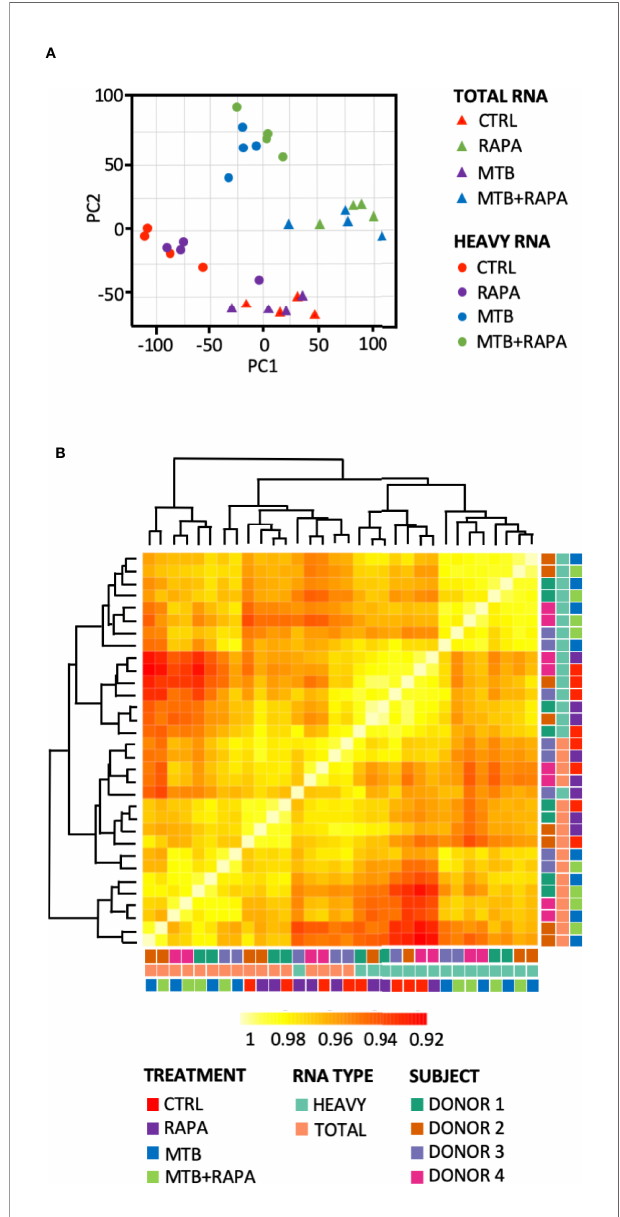
FIGURE 1 | Analysis of transcriptome and translatome of human DC infected with Mtb and treated with rapamycin. DC isolated from 4 healthy donors were left unstimulated (CTRL), treated with rapamycin (RAPA) or infected with Mtb alone (MTB) or in presence of rapamycin added 4 h post infection (MTB+RAPA). Cells were harvested 16 h post infection for total and polysome-associated RNA isolation and microarray analysis. (A) Principal component analysis of gene expression pro fi le of samples. Triangles indicate total RNA samples (TOTAL), circles refer to RNA fraction associated with polysome chains (HEAVY). (B) Heatmap showing hierarchical clustering of sample correlation. The dendrogram clusters together the signi fi cantly regulated treatment conditions with most similar expression pro fi les among the 4 donors. Correlation is represented by a color code according to the legend where yellow indicates higher correlation. A color code was used to distinguish among treatment conditions (CTRL, RAPA; MTB, MTB+RAPA), RNA type (TOTAL vs HEAVY) and DC culture prepared from different subjects (D1, D2, D3,